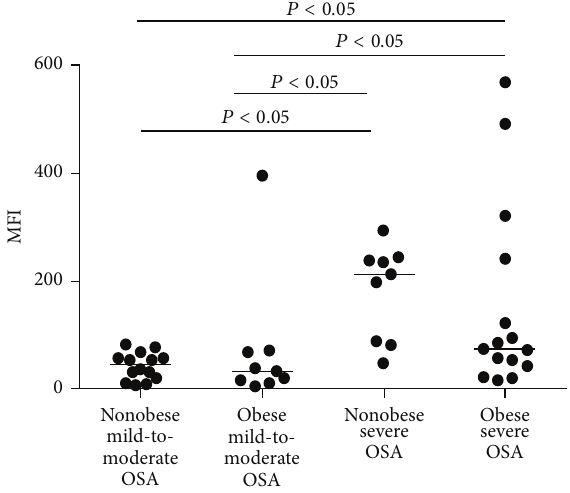
Figure 1: Neutrophil ROS production in obese and nonobese men with mild-to-moderate and severe obstructive sleep apnea. Data is presented as median. Significant differences between groups are marked. Comparisons of variables among four groups were made with Kruskal-Wallis test, followed by Bonferroni test. OSA: obstructive sleep